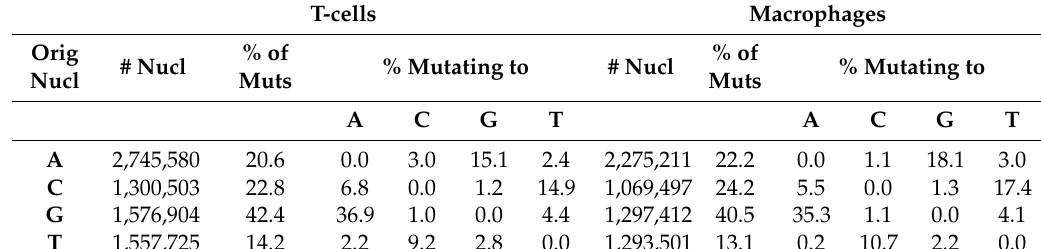
Table 4. Mutation patterns in T-cells and macrophages.